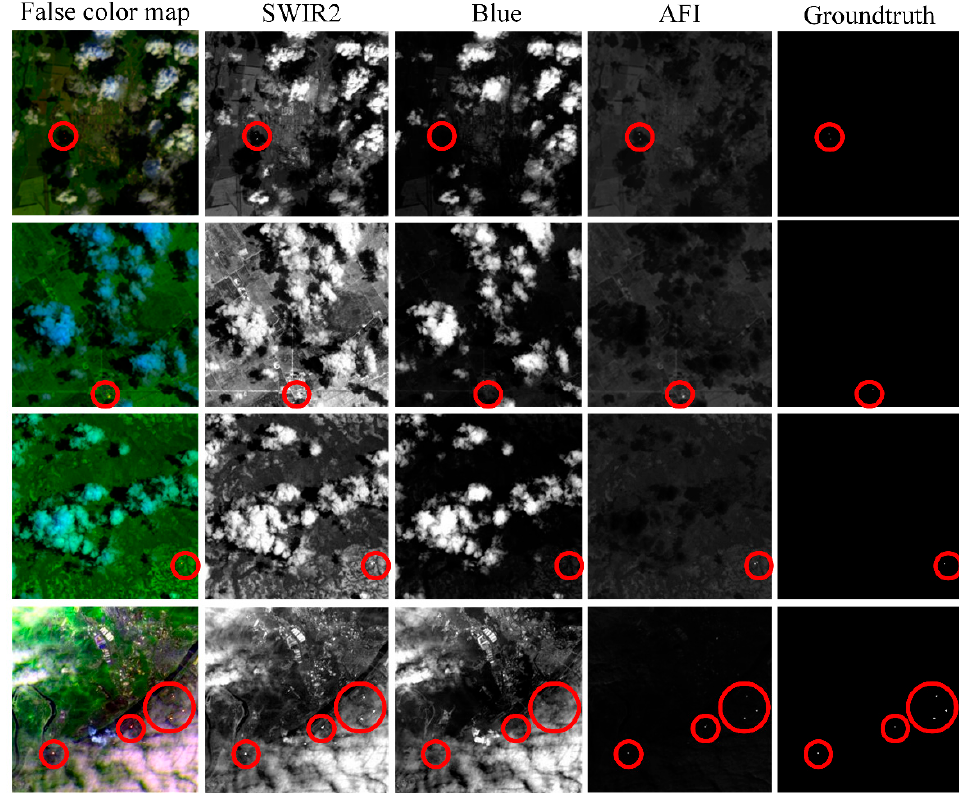
Figure 4. The performance of the AFI for AFD in cloudy scenes. Each row represents a sample image in the dataset with the red circles indicating the approximate fire range.